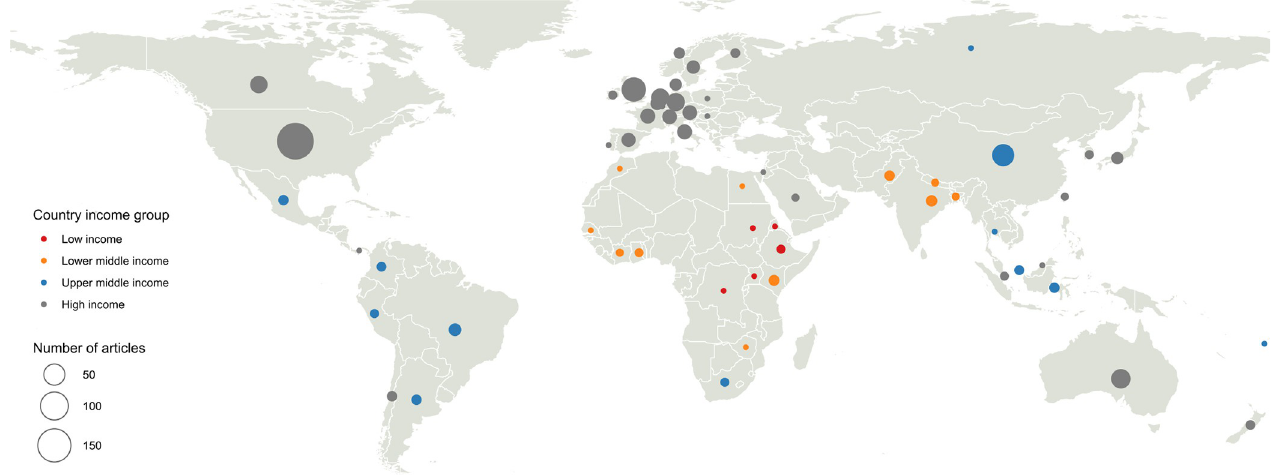
Fig 1. World map of the number of publications in sustainability science between 2018 and 2021. The number of articles is represented by circles of different sizes. The map was reprinted from https://www.naturalearthdata.com under a public domain license.